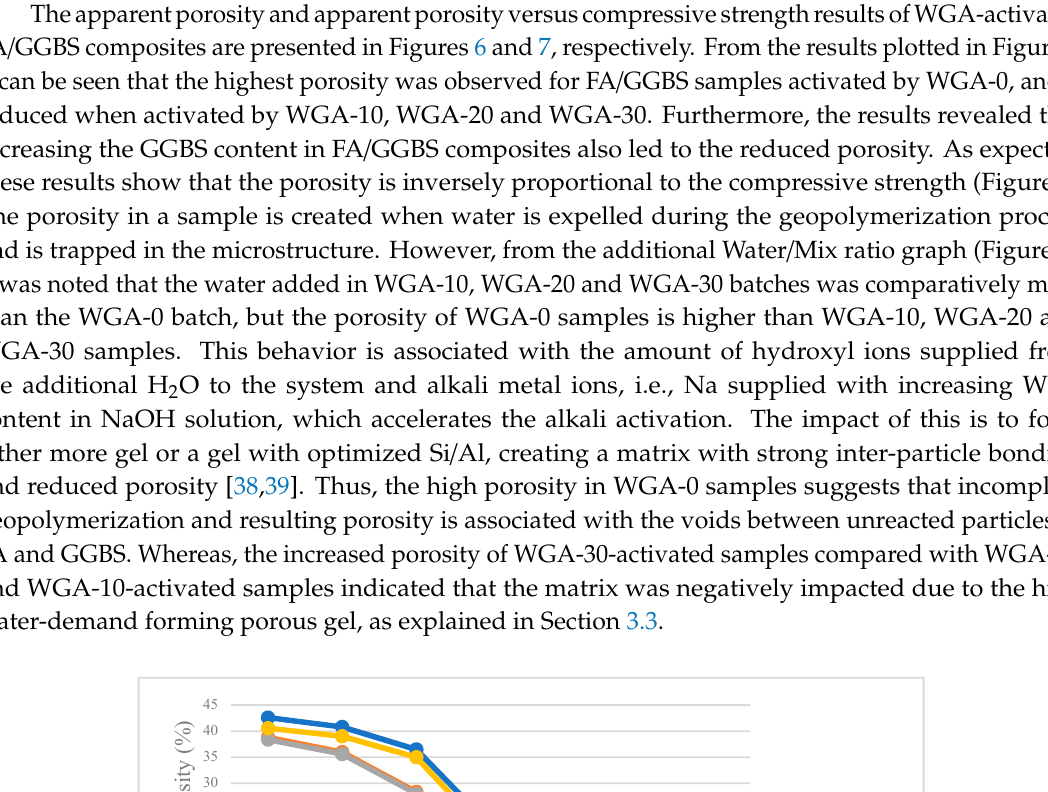
Figure 7. Apparent porosity versus compressive strength